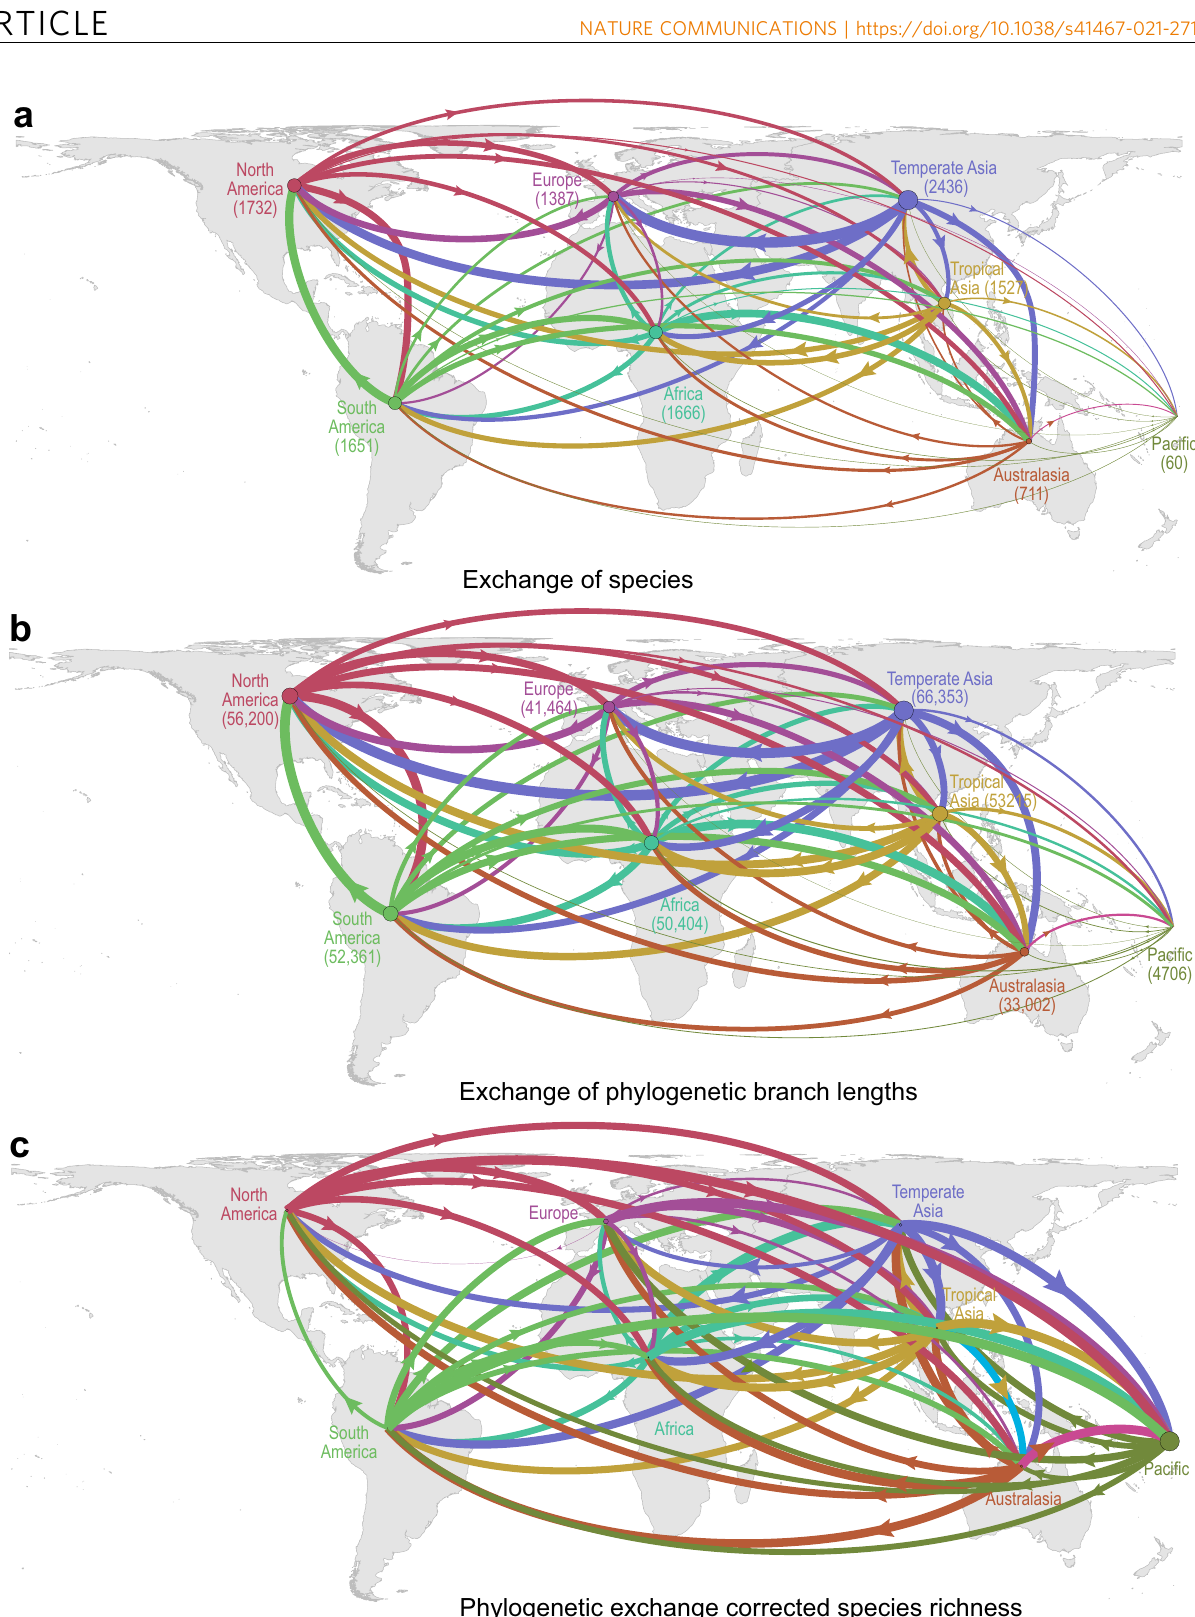
the guidelines of ODMAP (Overview, Data, Model, Assessment, Prediction), a comprehensive framework of best practices for reporting species distribution models 67 (see Supplementary Material 1). These maps were stacked and converted to a community matrix for downstream analyses. We also provide a new R function, sdm , for performing the SDMs across four algorithms (random forest, generalized linear models, gradient boosted machines, and MaxEnt) tailored for SDMs of large datasets. The sdm function is included in our R